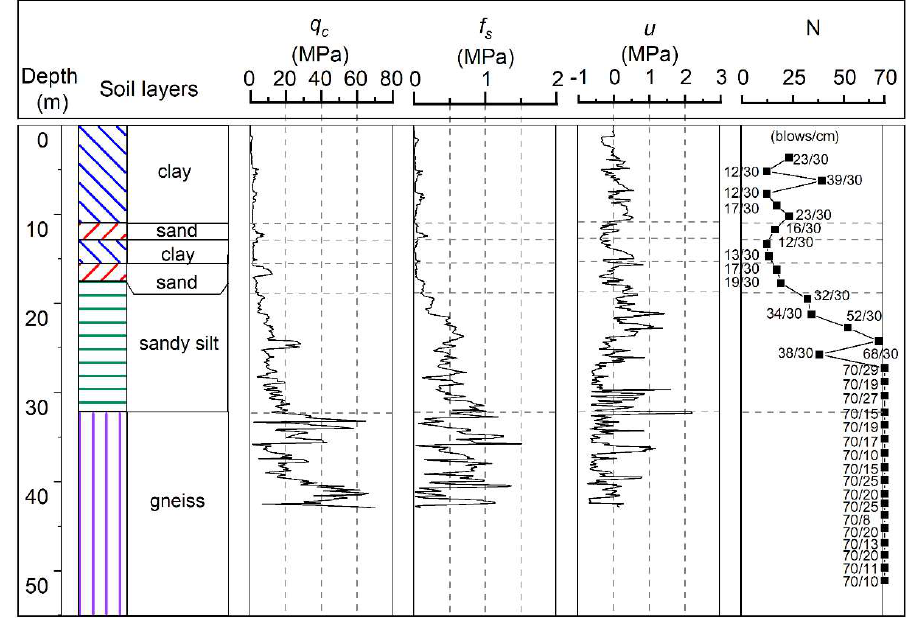
Figure 3. CPT and SPT results.